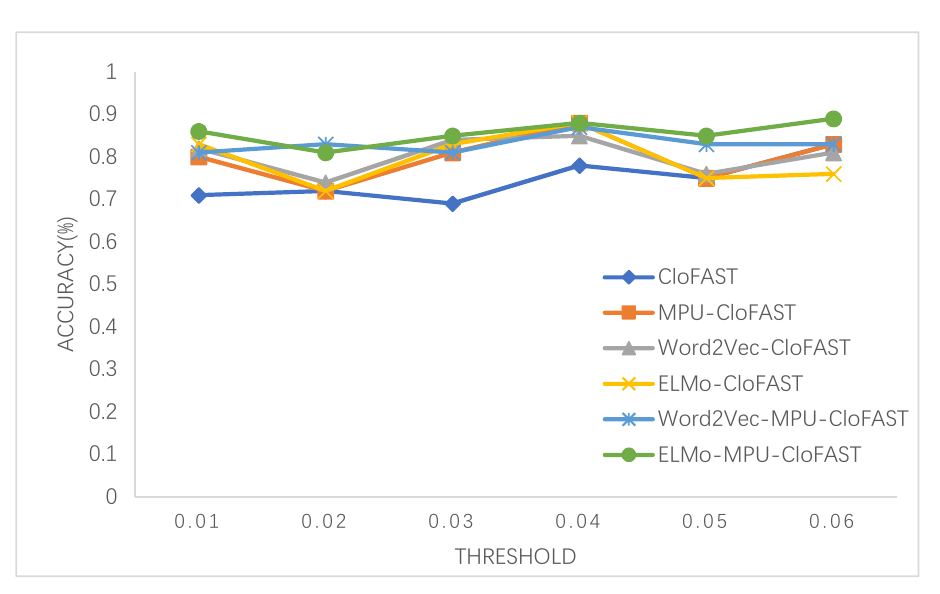
Table 6. The number of sequences under different methods.